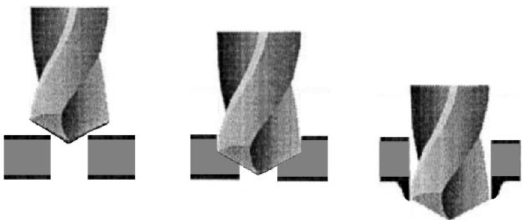
Figure 7. Burr formation when drilling using a pilot hole.